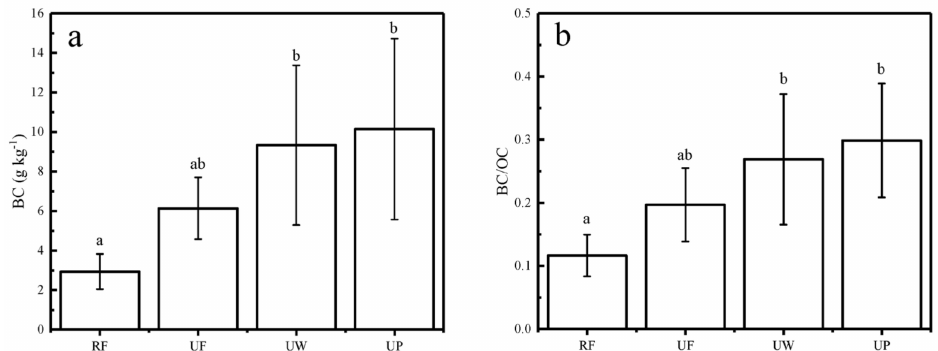
Figure 4. ( a ) Black carbon (BC) content in soils and ( b ) black carbon/organic carbon (BC/OC) ratio in soils. RF = rural forest, UF = urban forest, UW = urban woodland, and UP = urban park. Different letters indicate significant differences at different interference intensities at the level of α = 0.05.